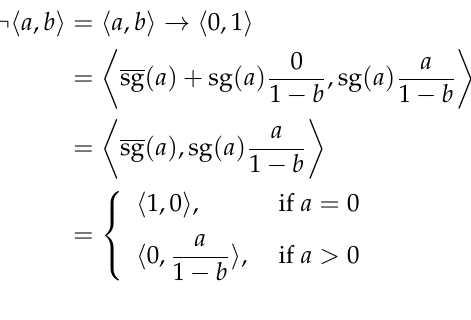
Figure 5. The geometrical interpretations of elements x , y and x → y : fourth scenario. The new implication generates the following